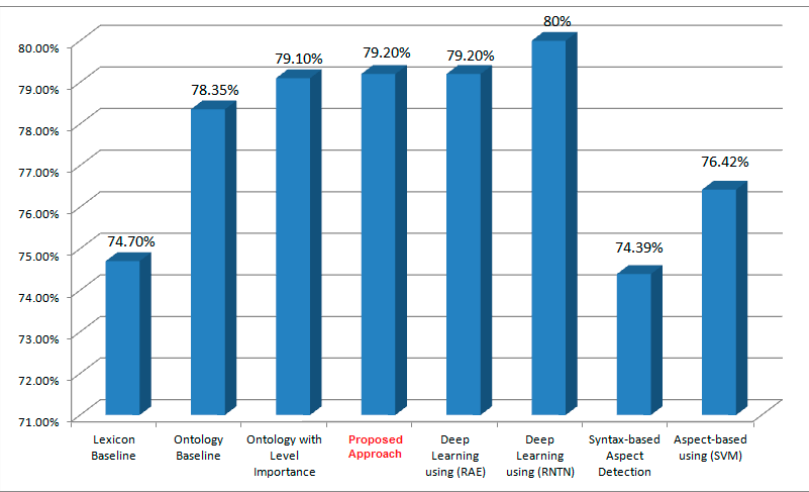
Figure 5. Accuracy of different state of the art approaches for ASA.